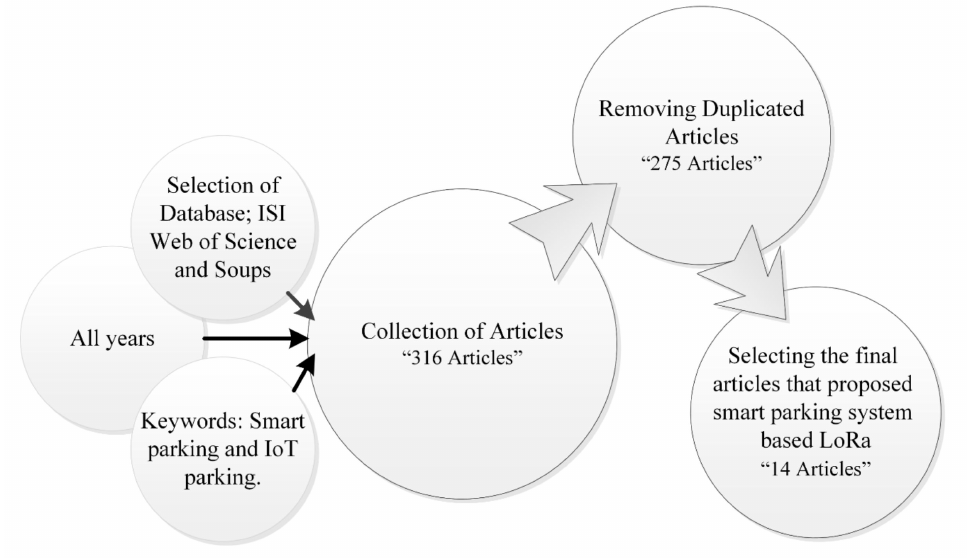
Figure 1. Related articles selection